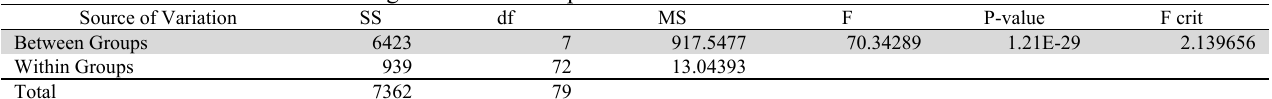
Source of Variation